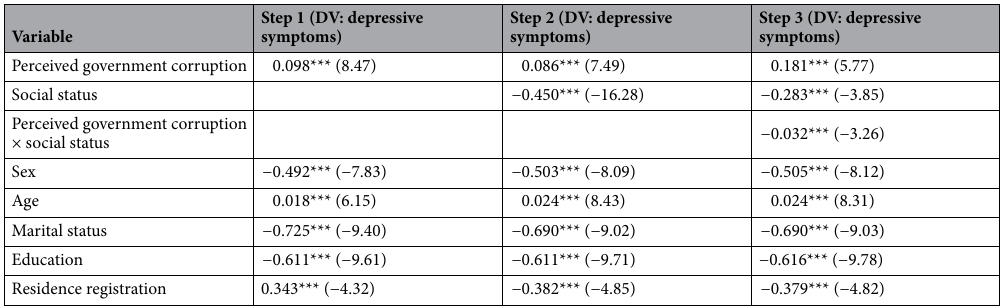
Table 4. Hierarchical regression results (N = 14,116). t-values in parentheses, ***p < 0.001, **p < 0.01, *p <